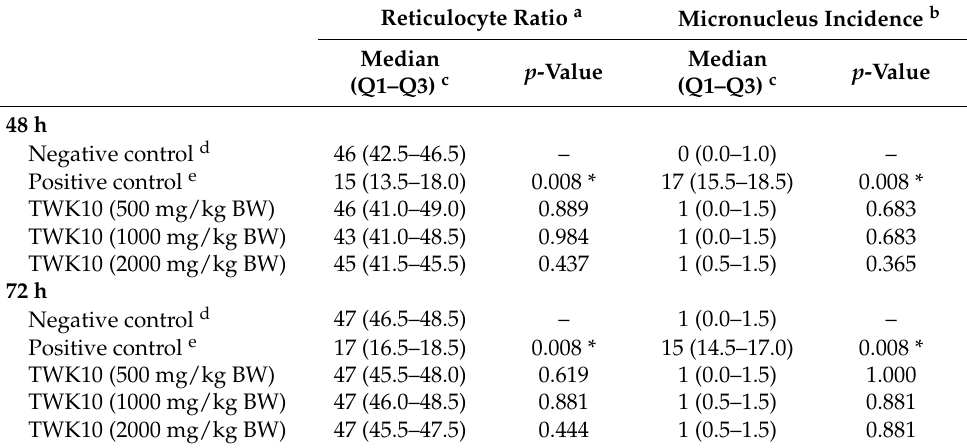
Table 5. Reticulocyte ratio and micronucleus incidence in peripheral blood of ICR mice adminis- tered